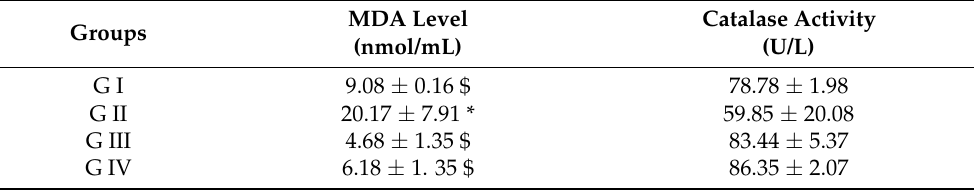
Table 3. Serum Malonaldehyde (MDA) and catalase activity levels in study groups.